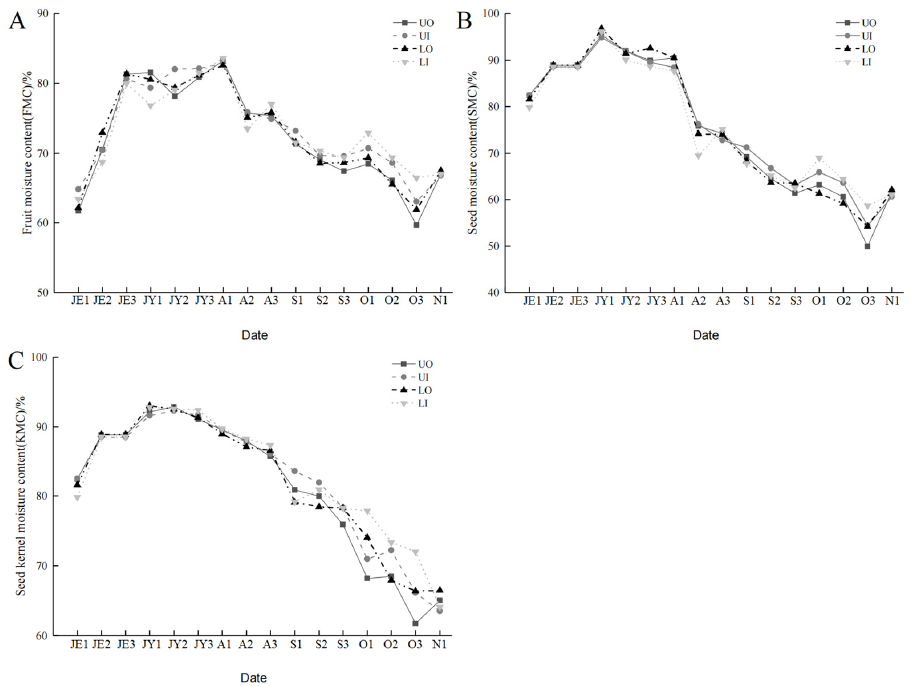
Figure 3. ( A ) Fruit moisture, ( B ) seed moisture, and ( C ) seed kernel moisture content in C. oleifera ‘Huaxin’ from June 2021 to November 2021.